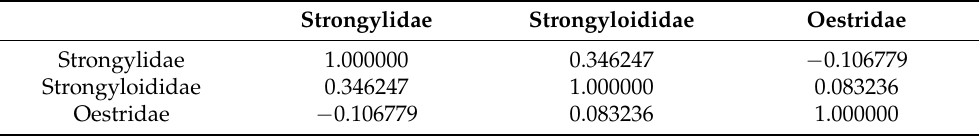
Table 3. Spearman correlation of ranks for parasites in stools.